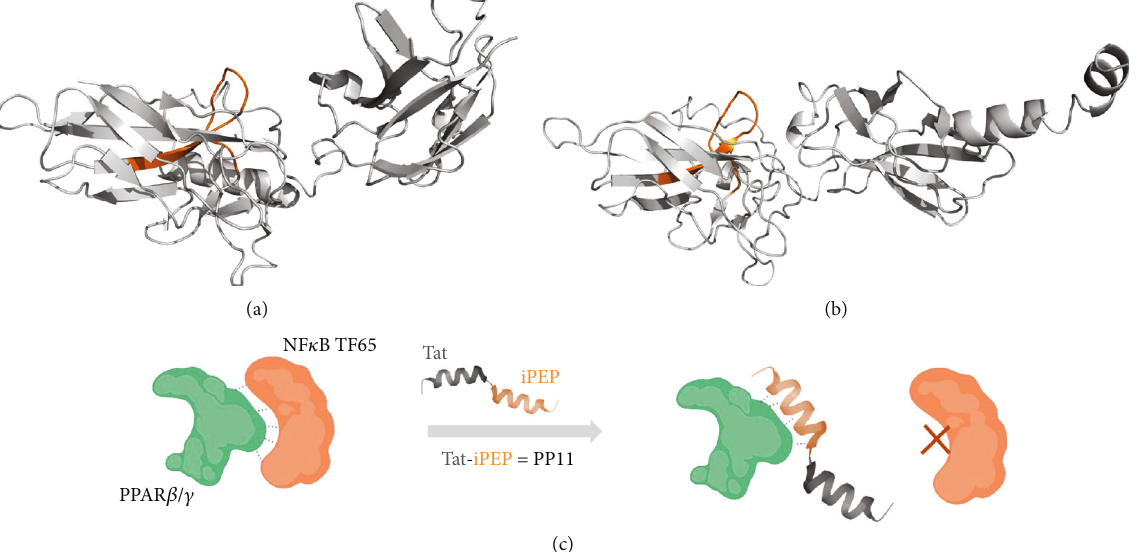
Figure 2: Visualization of the PP11 sequence with the TF65 structure. NF- κ B TF65 structures were extracted from the TF65:IRF-7:IRF- 3:DNA complex (PDB #2O61) [15] (a) and from the I κ B α :TF65 complex (PDB #1NFI) [14] (b). The PP11 peptide sequence situated in an accessible loop is highlighted in orange. Both 3D models were made using PyMol (c). Schematic representation of the PP11 peptide interaction mode: the PP11 peptide acts as a mimic of the NF- κ B TF65 subunit and prevents PPAR β / δ interaction to the NF- κ B TF65 subunit (scheme partially realized with BioRender,